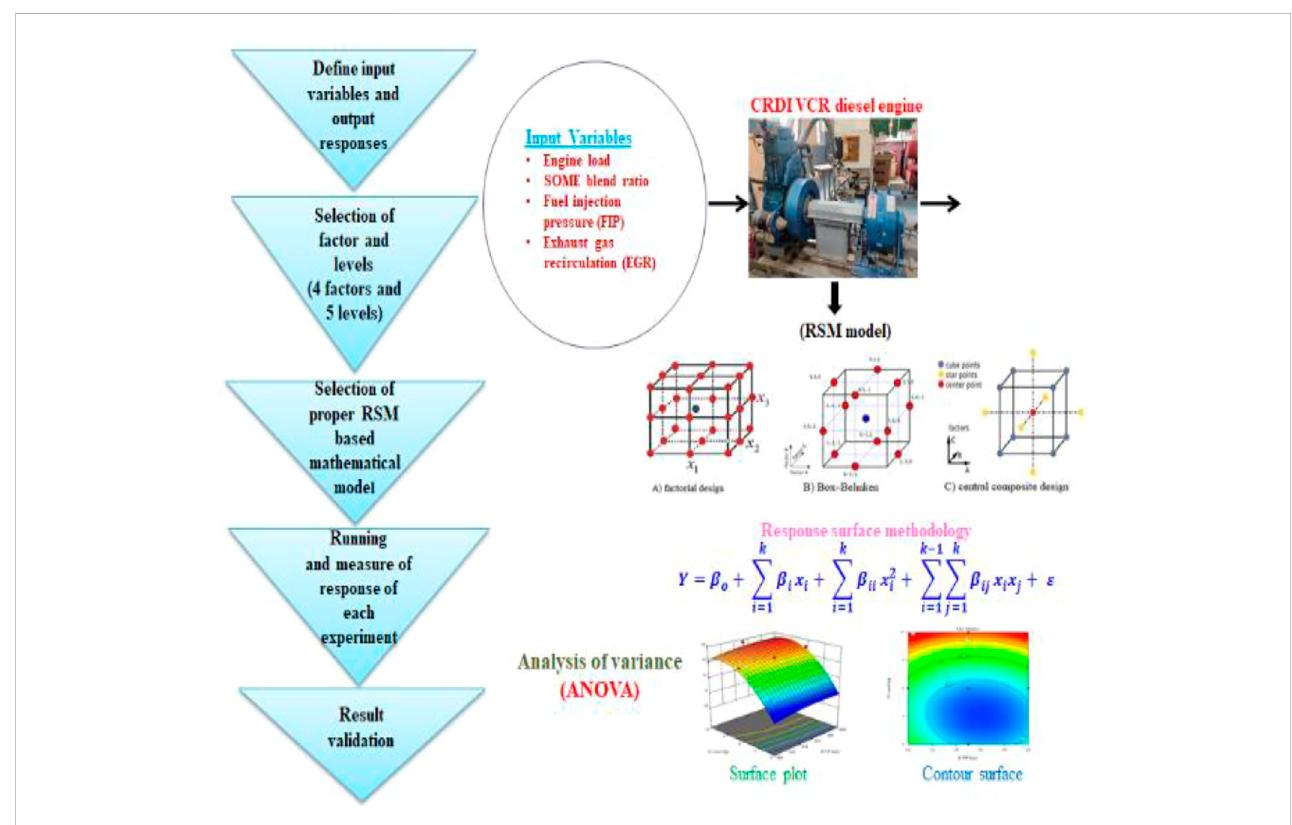
FIGURE 3 Description of optimization stages for the